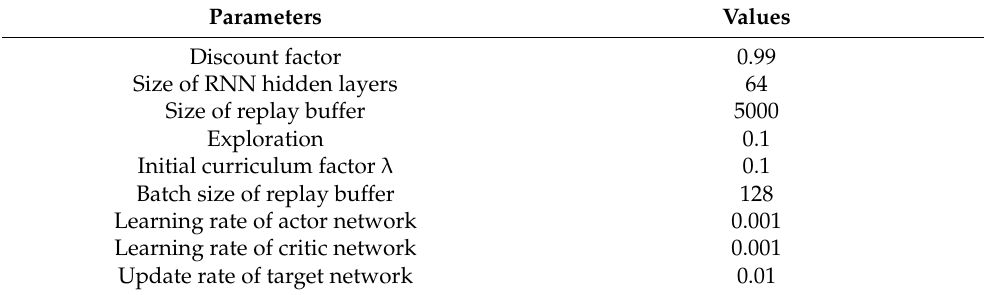
Table 1. Parameter setting of the DRL